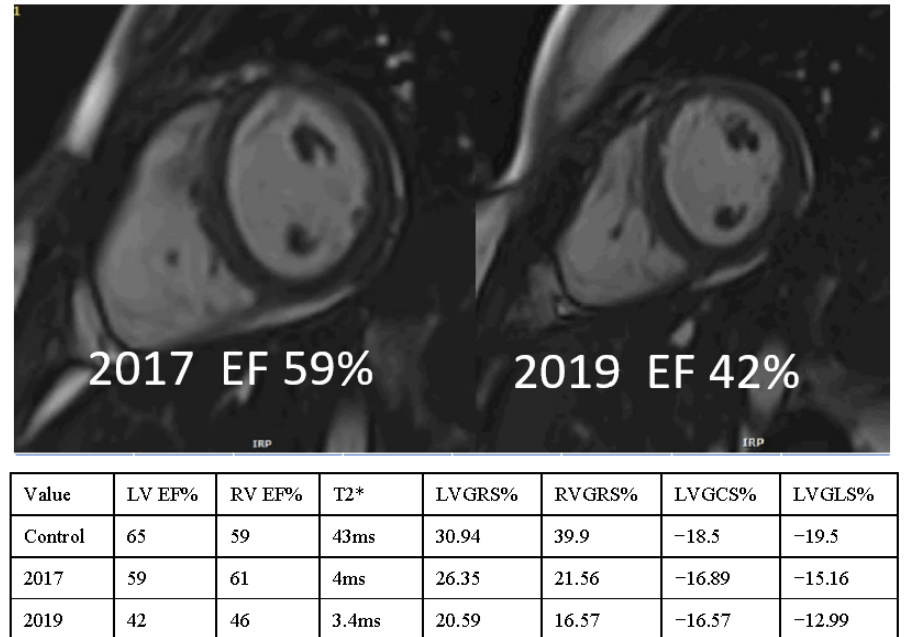
Figure 4. A 19 - yearold-girl with thalassemia major with deterioration of the cardiac increased MIO. The details of the parameters are noted in the attached table with a comparison of function due to increased MIO. The details of the parameters are noted in the attached their respective values. table with a comparison of their respective values.